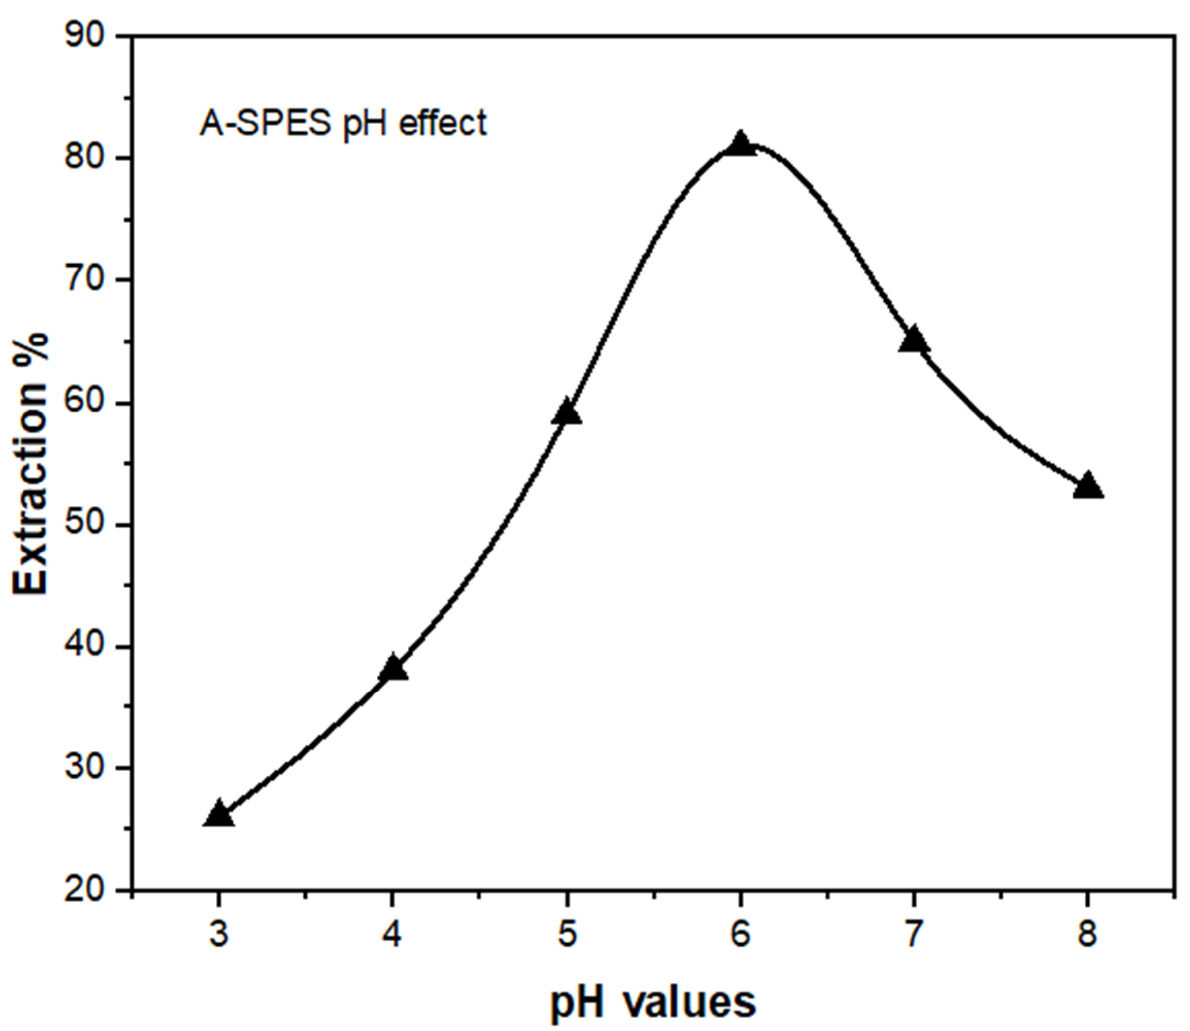
Figure 8. The effect of pH values on the adsorption of Co(II) ions (2 mg/L) on 30 mg of A-SPES at 25 °C.